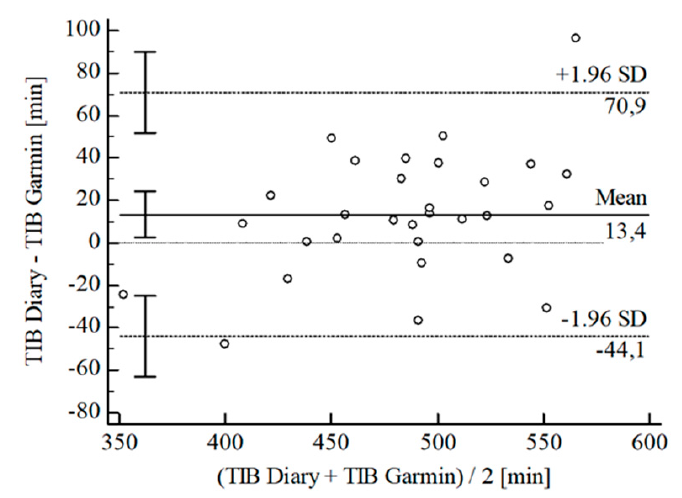
Figure 4. Bland-Altman plot for TIB Garmin ® vs. diary.